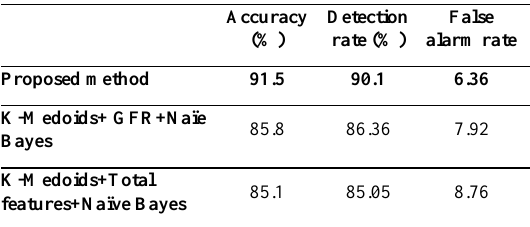
Table 5. Comparison between accuracy and detection rate. Accuracy